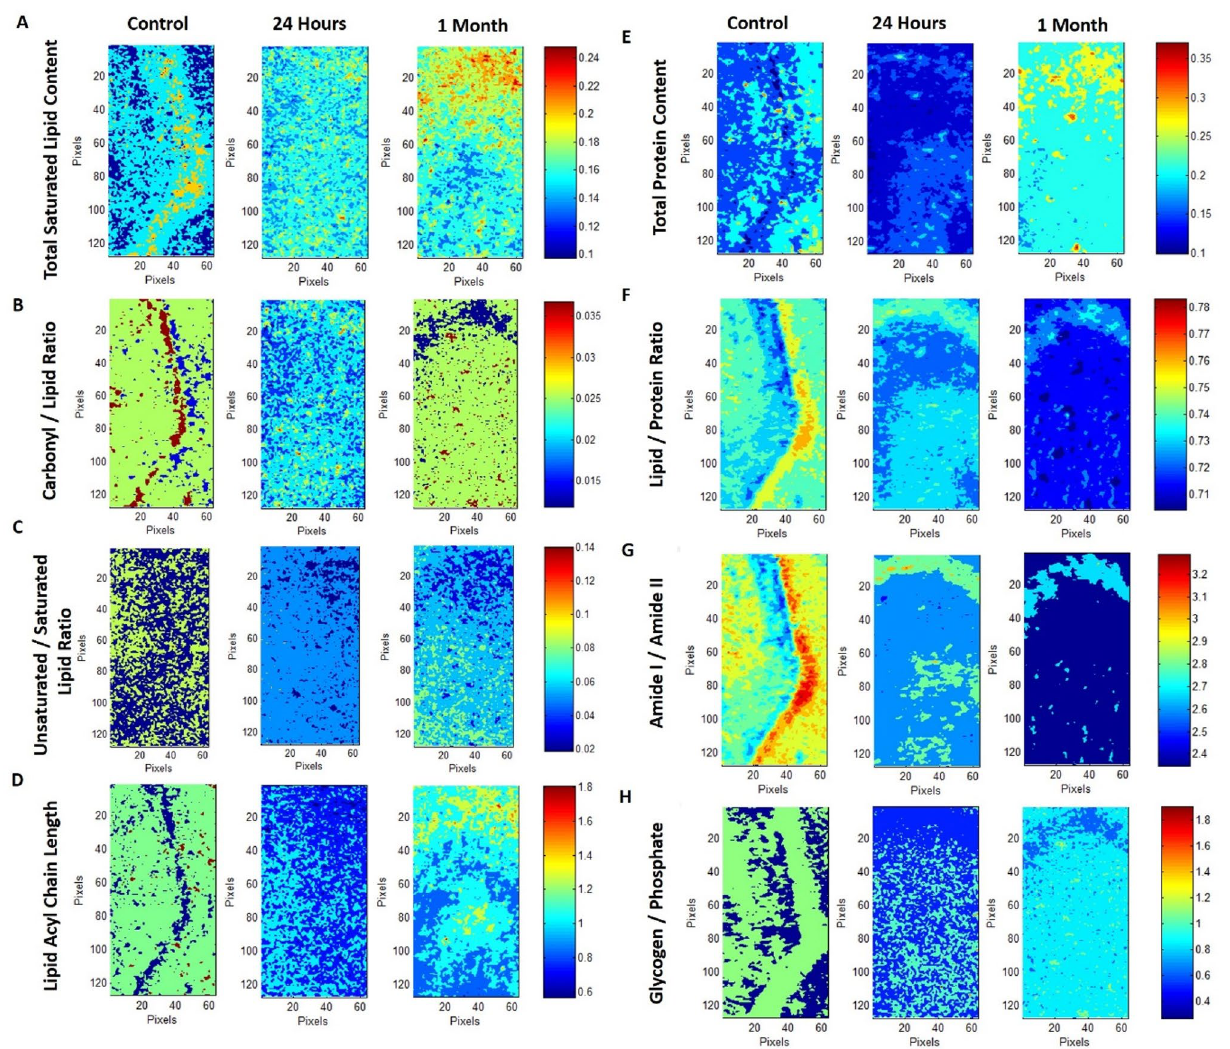
Figure 2. Typical FTIR images of total saturated lipid content ( A ), carbonyl/lipid ( B ), unsaturated/saturated lipid ( C ), lipid acyl chain length ( D ), total protein content ( E ), lipid/protein ( F ), amide I/amide II ( G ) and glycogen/phosphate ( H ) band area ratios in left hippocampal tissue of control, 24 h and 1-month TBI groups. Color bars represent the scales for each of the parameters. Axes are in pixels, where one pixel is 6.5 μm. The pixel histograms for these images are shown in Fig.